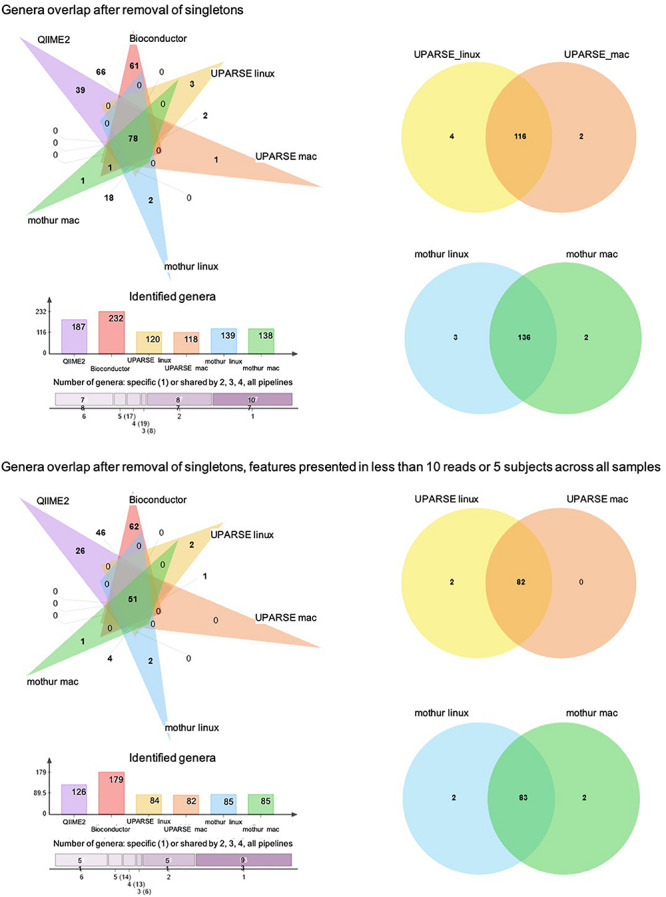
Venn diagram showing the number of shared and specific bacterial genera among the pipelines. Histogram representing the number of genera identified by each pipeline and number of genera shared between 6, 5, 4, 3, 2, and no pipelines are also reported.